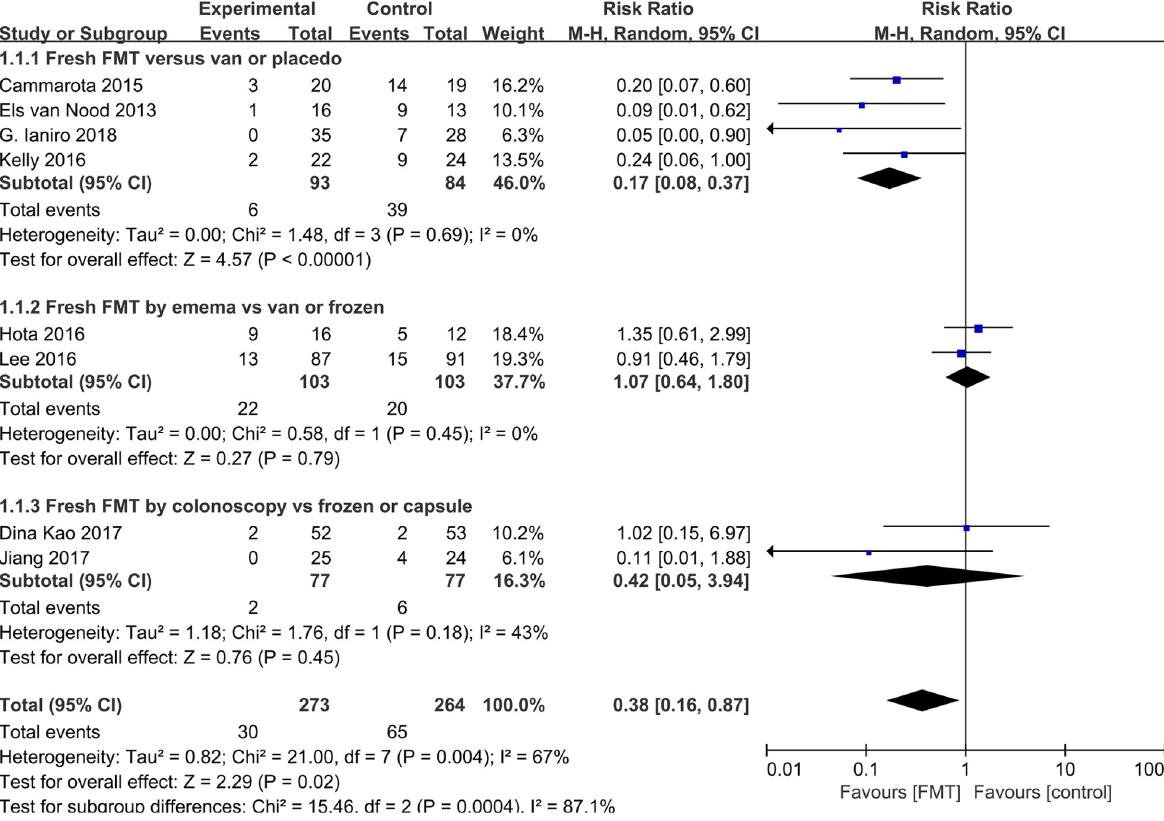
Fig 3. Meta-analysis of the RR between the intervention group and the control group.